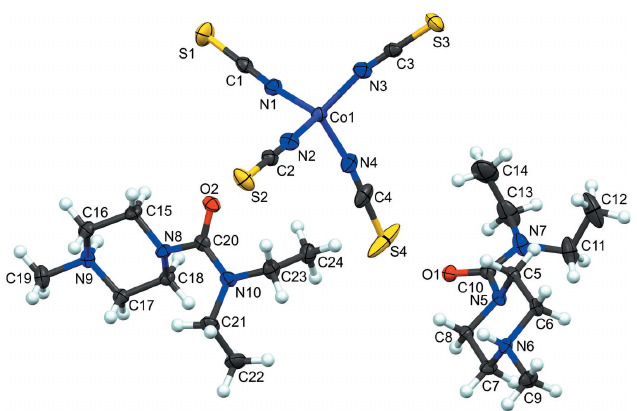
Figure 1 Molecular structure of bis(diethylcarbamazide) tetrakis(isothiocyanato)- cobalt(II). Atomic displacement ellipsoids depicted at the 50% probability level. Hydrogen atoms are shown as spheres of an arbitrary radius.